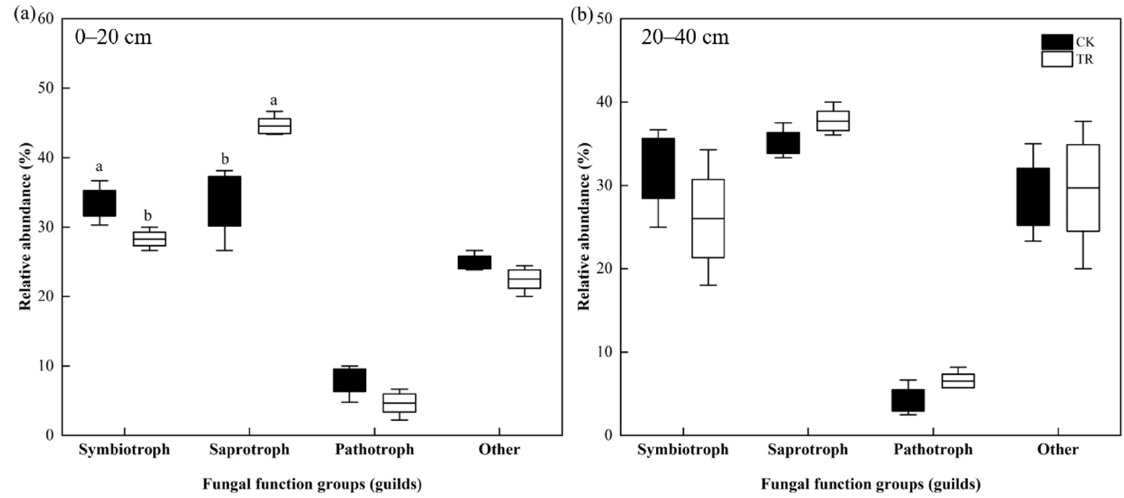
Figure 7. Effects of throughfall reduction on fungi trophic mode in 0–20 cm ( a ) and 20–40 cm ( b ) soil depth. Different lowercase letters represent significant differences between CK and TR treatment.